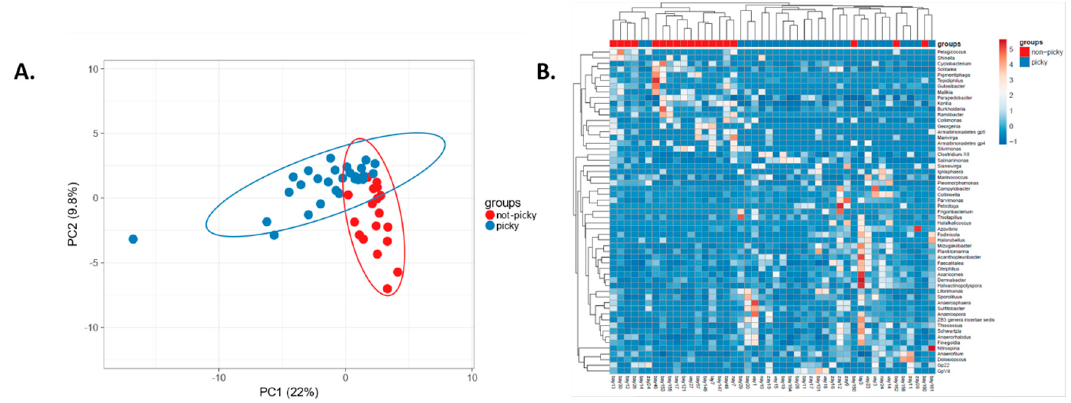
Figure 4. Diversity of intestinal microbiota at the genus level in “picky eaters” compared to “non-picky eaters”. A . PCA ClustVis. B . Heatmap ClustVis, significantly differently abundant genera.